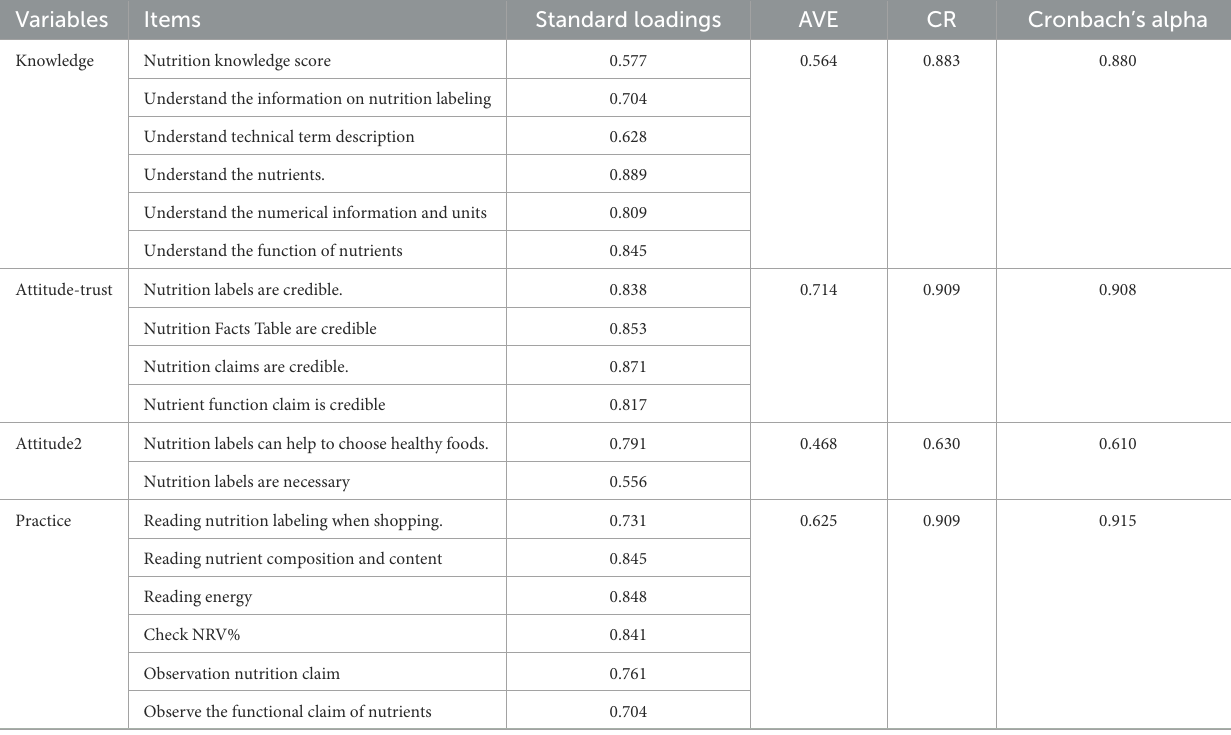
is superior to multiple linear regression modeling. The structural equation model can analyze multiple dependent variables at the same time, and its application is helpful to scientifically analyze